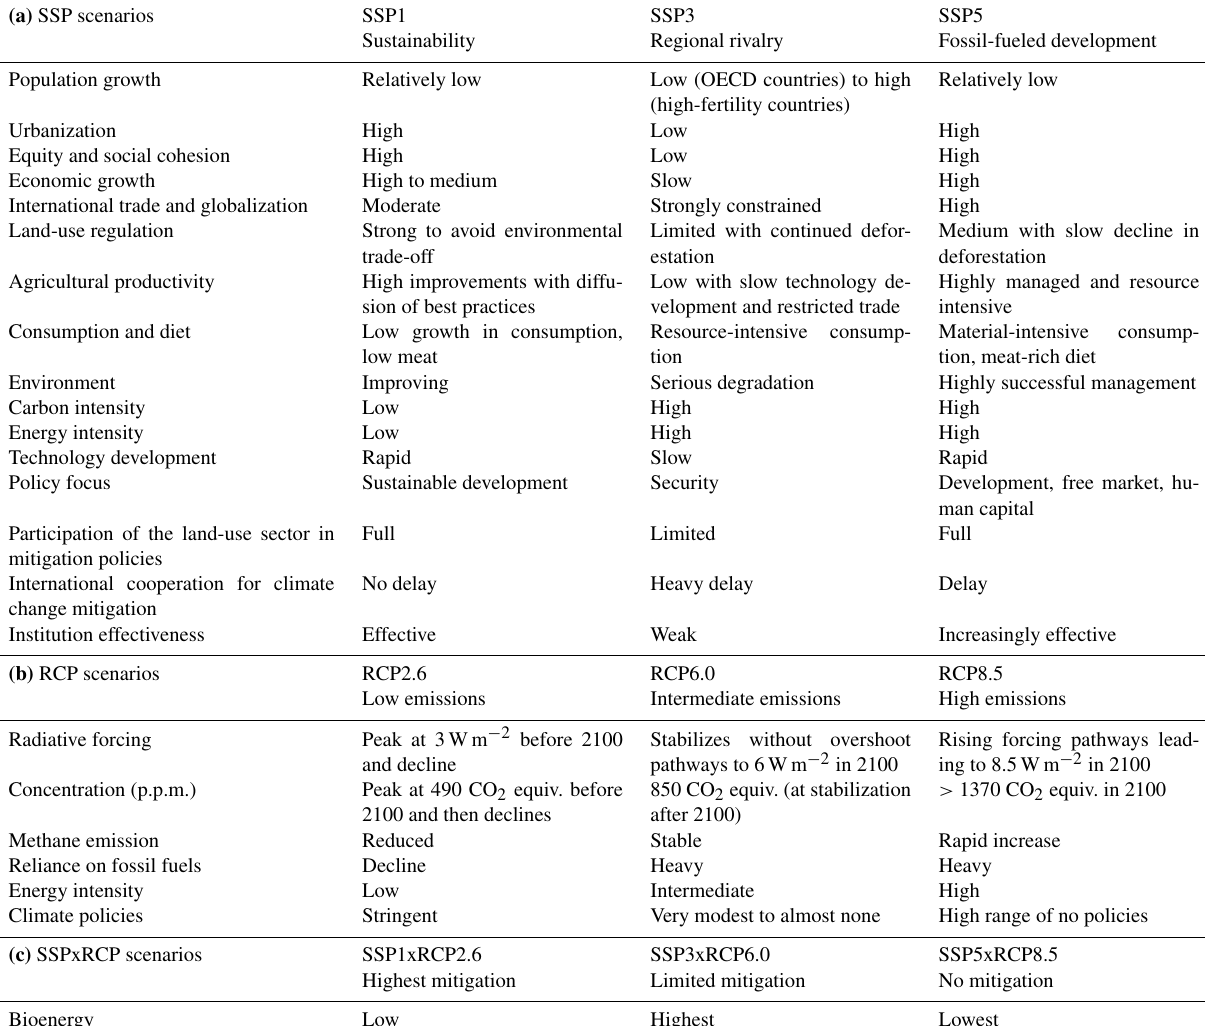
Table 1. Characteristics of the (a) SSP, (b) RCP and (c) SSPxRCP scenarios simulated in BES-SIM (adapted from Moss et al., 2010; O’Neill et al., 2017; Popp et al., 2017; van Vuuren et al., 2011).